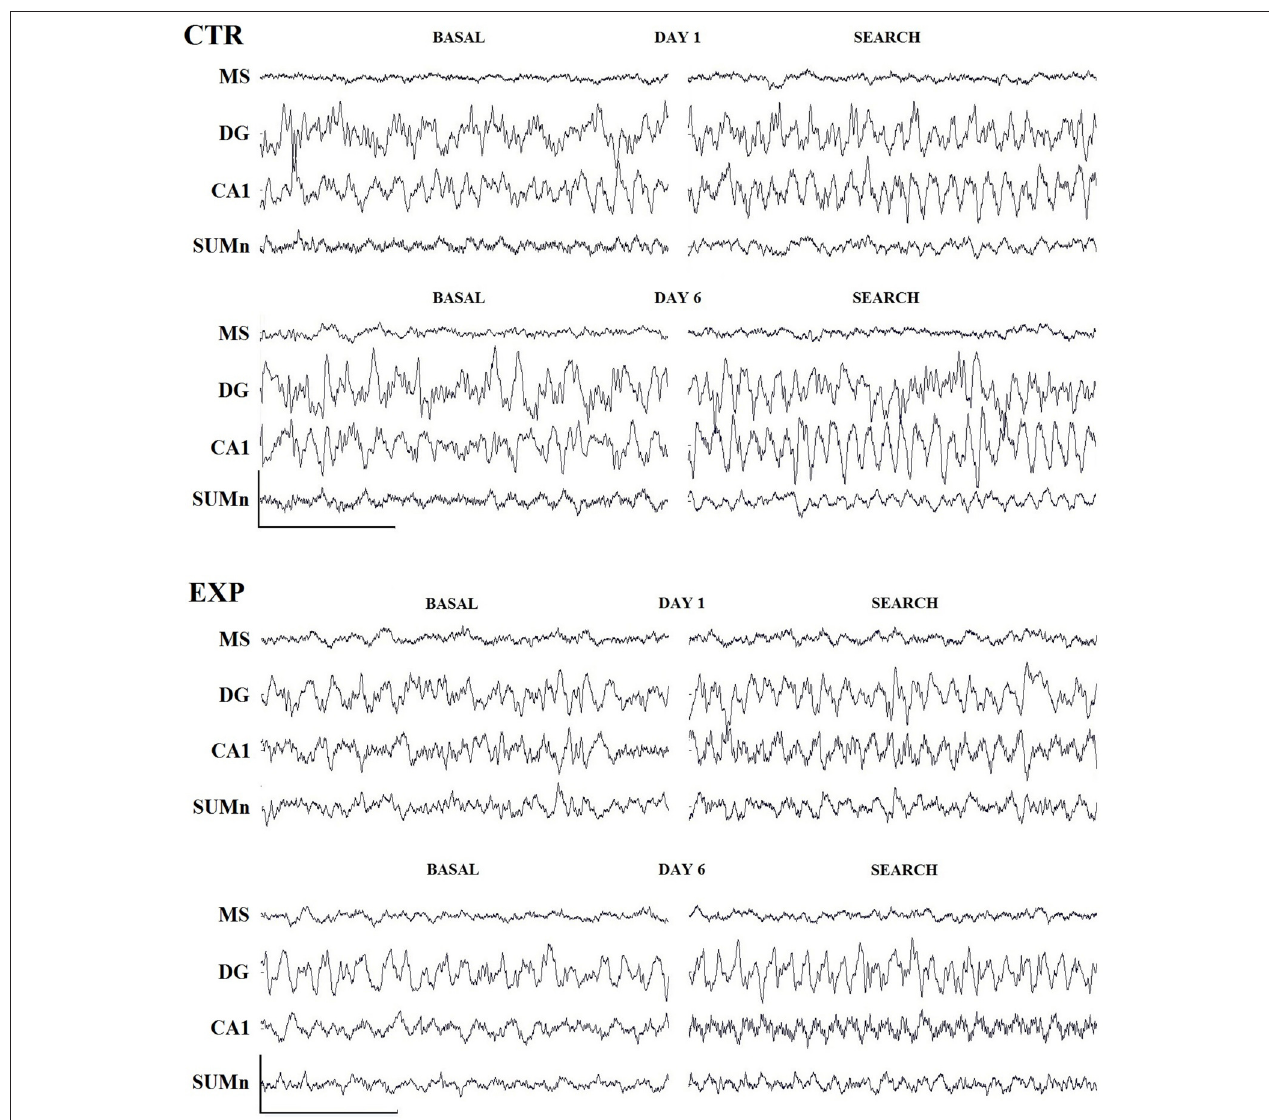
FIGURE 3 | Row traces of one representative rat from each group. Three second samples recorded during basal conditions (awake, wet rat in a holding cage) and during the search for the platform on days 1 and 6 of training. Cal. 500mV/1s. Abbreviations are as in the